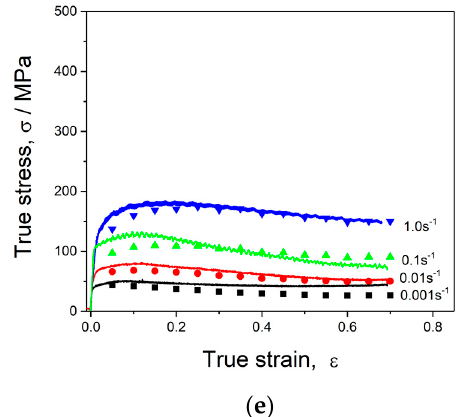
Figure 8. Comparison between experimental and predicted flow stresses of the PM/Wrought dual superalloy at deformation temperatures of ( a ) 1020 °C; ( b ) 1050 °C; ( c ) 1080 °C; ( d ) 1110 °C; ( e ) 1140 °C.